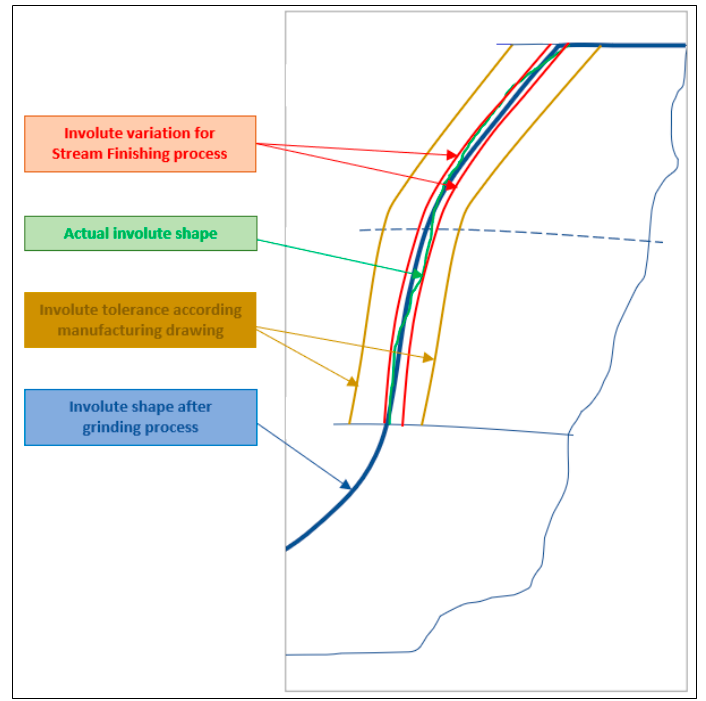
Figure 21. Involute shape variation for the Stream Finishing process.